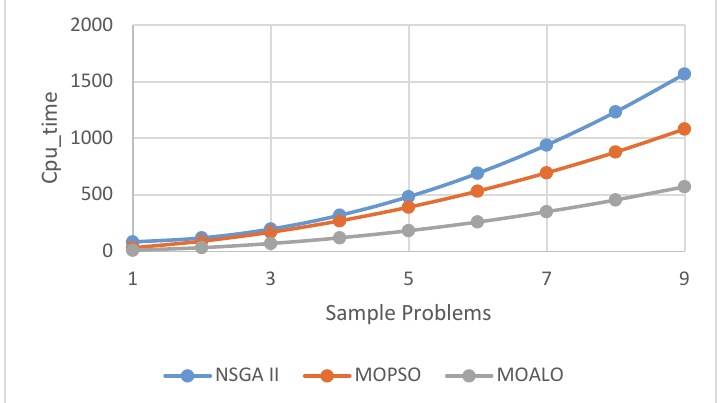
Fig. 18 . Changes in computational time averages in large sample